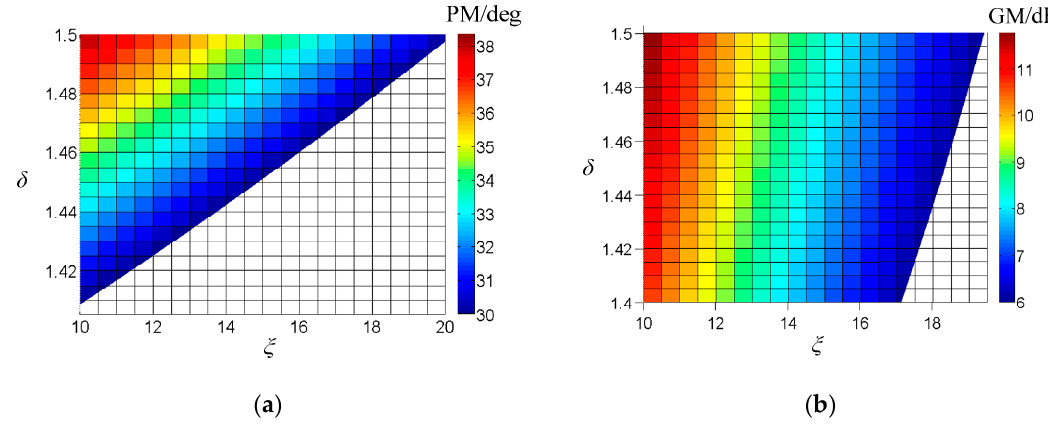
Figure 7. Stability margin as a function of ξ and δ : ( a ) Phase margin, ( b ) Gain margin.